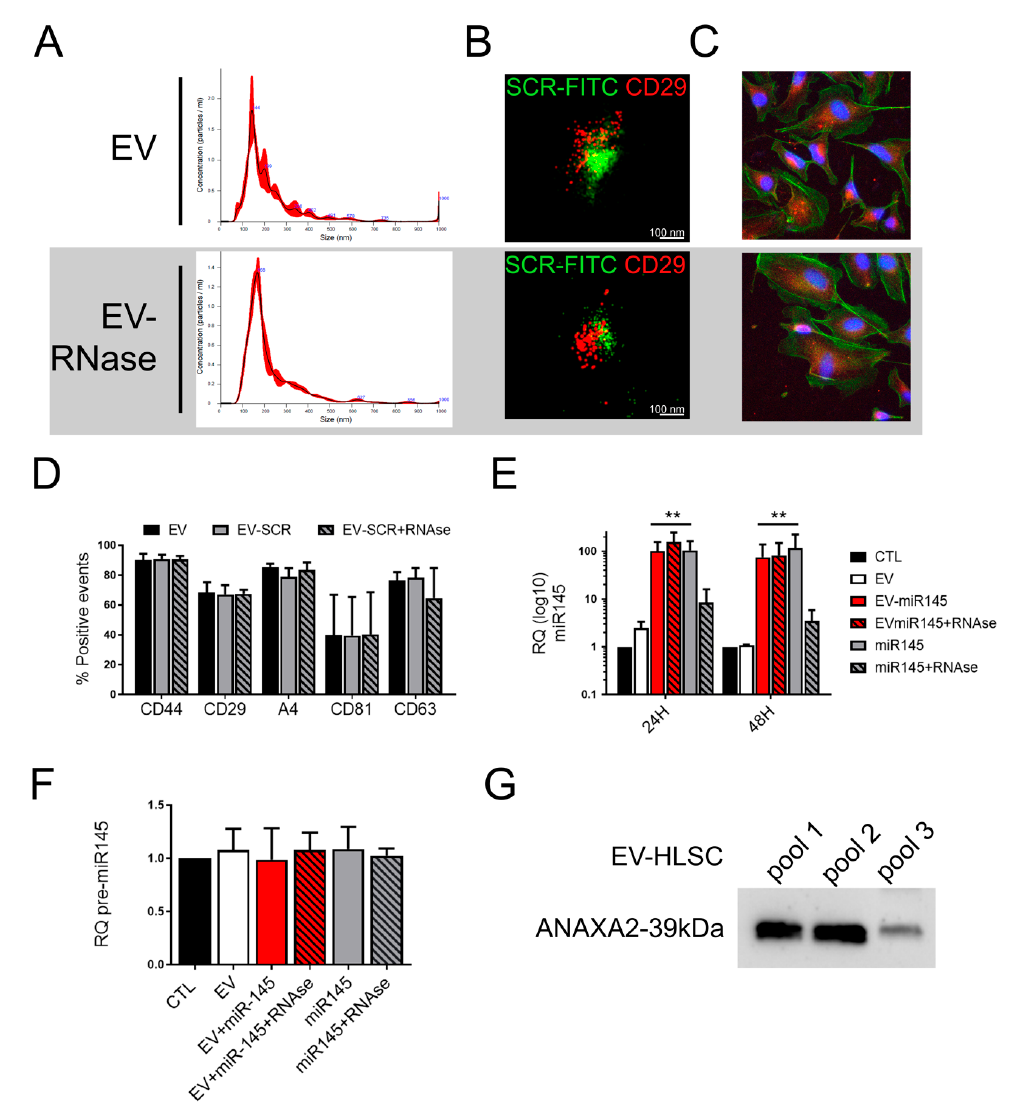
Figure 2. Integrity of miR145 coincubated HLSC-EVs after RNase treatment. ( A ) NanoSight distribution graph showing the quantity and size of HLSC-EVs untreated (Pre-RNase) or digested with 0.1 ng/ µ L RNase-A (RNase 0.1 ng/ µ L). ( B ) Super resolution microscopy micrographs showing the effective loading of a scrambled FITC sequence (green). HLSC-EVs are labeled with anti-CD29 Ab (red). Scale bar: 100 nm. ( C ) Representative micrographs of incorporation of DIL-labeled HLSC-EVs (EV) and DIL-labeled HLSC-EVs treated with 0.1 ng/ µ L RNase-A (EV-RNase) in rCSCs after 1 h of incubation detected by confocal microscopy (original magnification 400 × ). ( D ) Immunophenotypic characterization of HLSC-EVs (EV) loaded with a scrambled sequence (EV-SCR) and treated with 0.1 ng/ µ L RNase-A (EV-SCR + RNase), expressing the markers of cells of origin (CD44, CD29 and integrin alpha4 (A4)), together with the exosomal markers CD63 and CD81. Results are mean ± SD of the percentage of positive events of four different independent EV preparations. ( E ) Real Time analysis showing miR-145 levels in rCSCs treated for 24 h or 48 h with naïve HLSC-EVs (EV), HLSC-EVs coincubated with miR-145 untreated (EV-miR145) or digested with 0.1 ng/ µ L RNase-A (EV-miR145 + RNAse), or with free miR-145 untreated (miR145) or digested with 0.1 ng/ µ L RNase-A (miR145 + RNAse). Data are represented as mean ± SD of four independent experiments of the Relative Quantification (RQ) normalized to untreated cells (CTL) and to RNU6B. One-way ANOVA was performed: ** = p < 0.001 vs. CTL. ( F ) Real Time analysis showing pre-miR-145 levels in rCSCs treated for 24 h with naïve HLSC-EVs (EV), HLSC-EVs coincubated with miR-145 untreated (EV-145) or digested with 0.1 ng/ µ L RNase-A (EV-145 + RNAse), or with free miR-145 untreated (miR145) or digested with 0.1 ng/ µ L RNase-A (miR145 + RNAse). Data are represented as mean ± SD of three independent experiments of the Relative Quantification (RQ) normalized to untreated cells (CTL) and to RNU6B. ( G ) Western blot analysis of three different HLSC-EVs preparations (pool1, pool2, pool3) showing the presence of Annexin A2